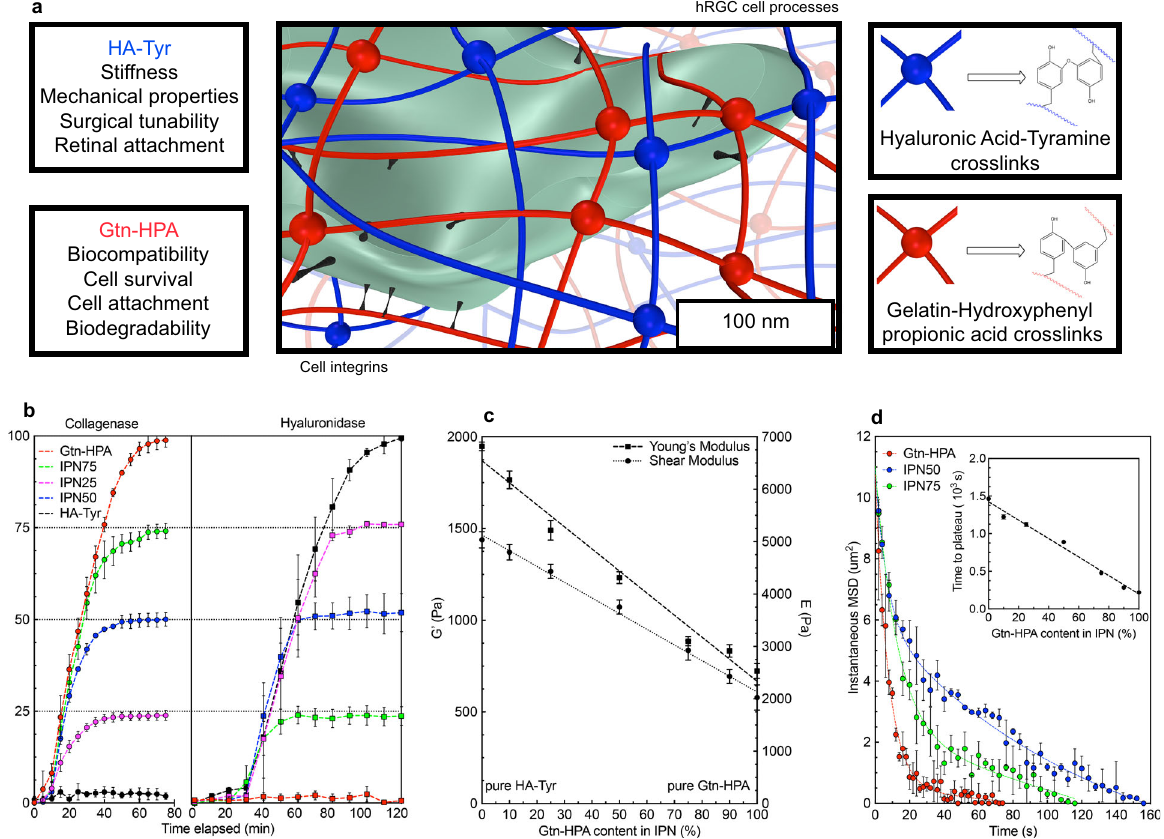
Fig. 1 The Gelatin and Hyaluronic Acid interpenetrating network system and its mechanical and chemical characterization. a Schematic and 3D model of a human cell encapsulated in the IPN made of Gelatin-HPA (red) and HA-Tyr (blue) with integrins bonding to Gtn-HPA only (black). Legends shows the two different crosslinks with their respective chemical structures. b Hydrogels ’ degradation assays performed with Collagenase and Hyaluronidase treatment for Gtn-HPA (red), IPN75 (green), IPN50 (blue), IPN25 (pink) and HA-Tyr (black). Degradation assay, comprising n = 15 replicates, was measured every 5 min with collagenase and every 10 min with Hyaluronidase. c Shear (dot line) and Young ’ s (dash line) moduli measurements for multiple IPN with different Gtn-HPA content (ranging from 10% to 90%). Linear regression was applied both set of values, with n = 15. d Mean square displacement measurements of PLGA microbeads encapsulated in materials during microrheology assay for Gtn-HPA (red), IPN75 (green) and IPN50 (blue). N = 15 microbeads were tracked for each sample and the data were fi tted with a double exponential decay regression. Inset ( d ) shows the time to reach stability of the different IPN during the gelation process. Linear regression was applied to the data con fi rming the increase of gelation time with the addition of HA-Tyr in the mix. All data is shown as mean ± SEM.